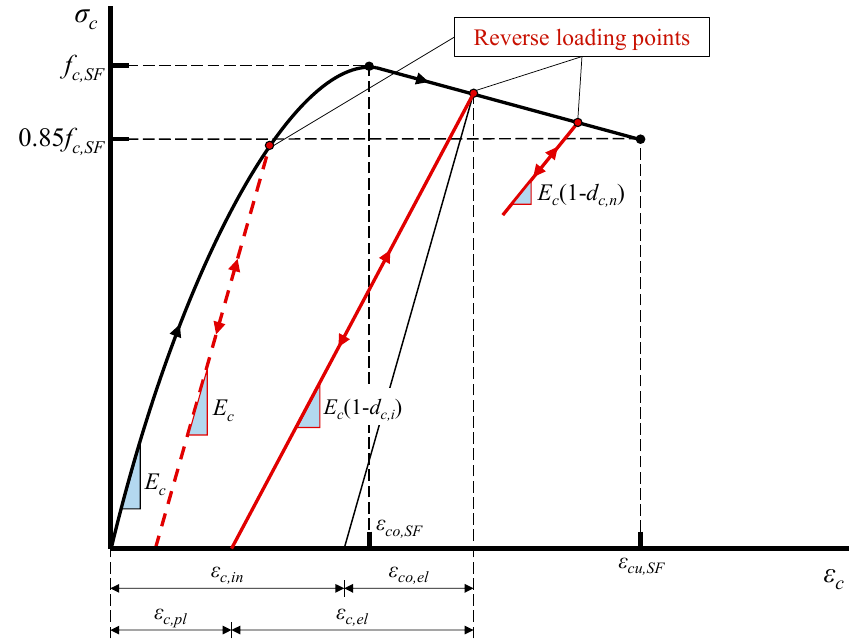
Figure 4. Model of SFRC under reversal compression.